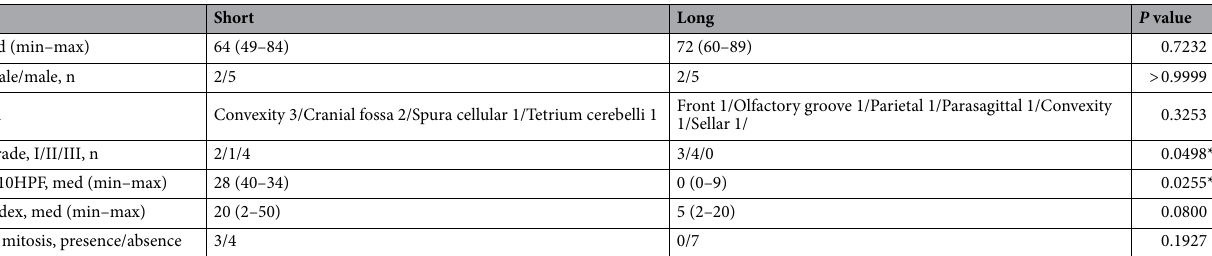
Table 1. Clinicopathological characteristics of meningioma with short or long telomere. Patients were divided into two groups according to the median value of normalized telomere length (cutoff value, 1.072). HPF high- power fields, WHO World Health